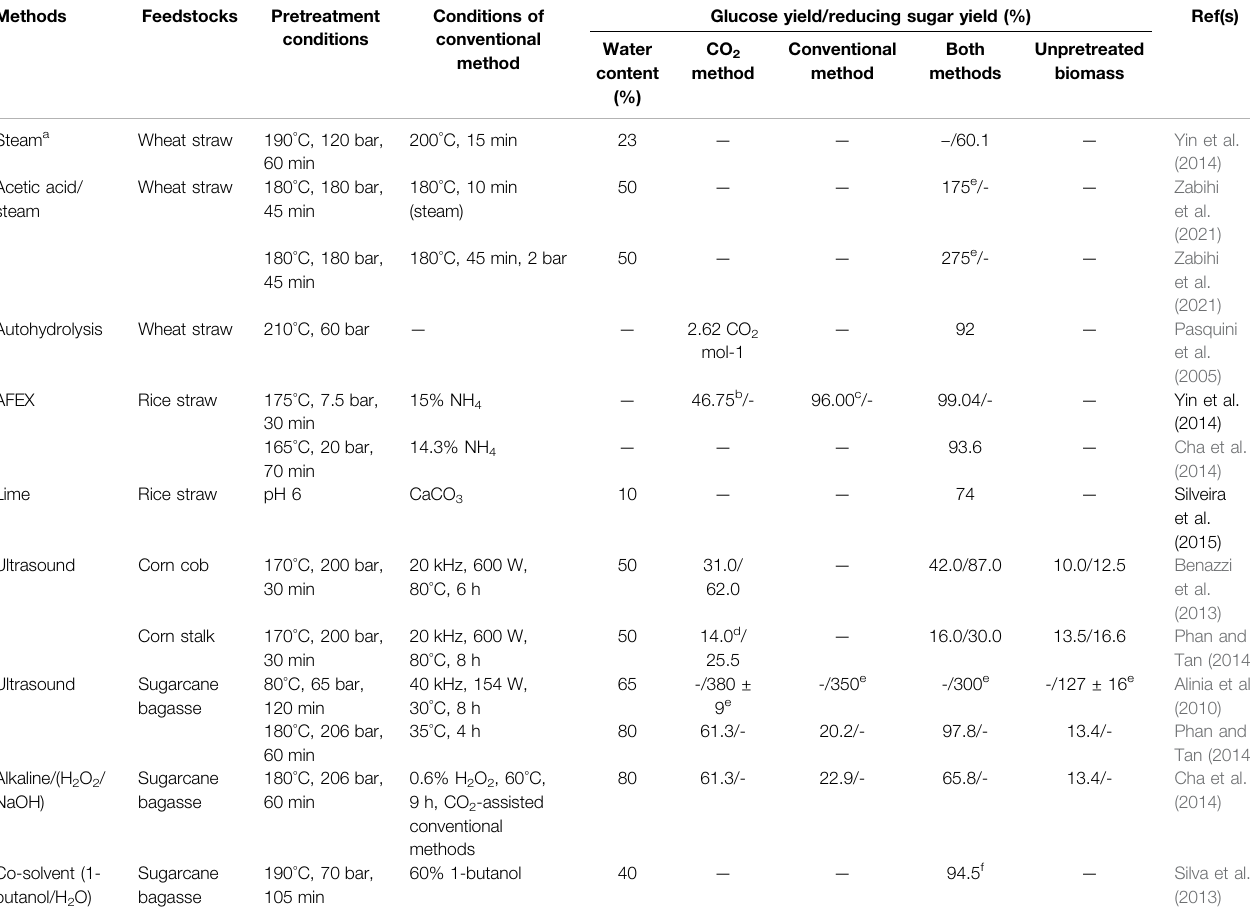
TABLE 4 | Sc-CO 2 combined with conventional treatment methods for biomass pretreatment. Methods